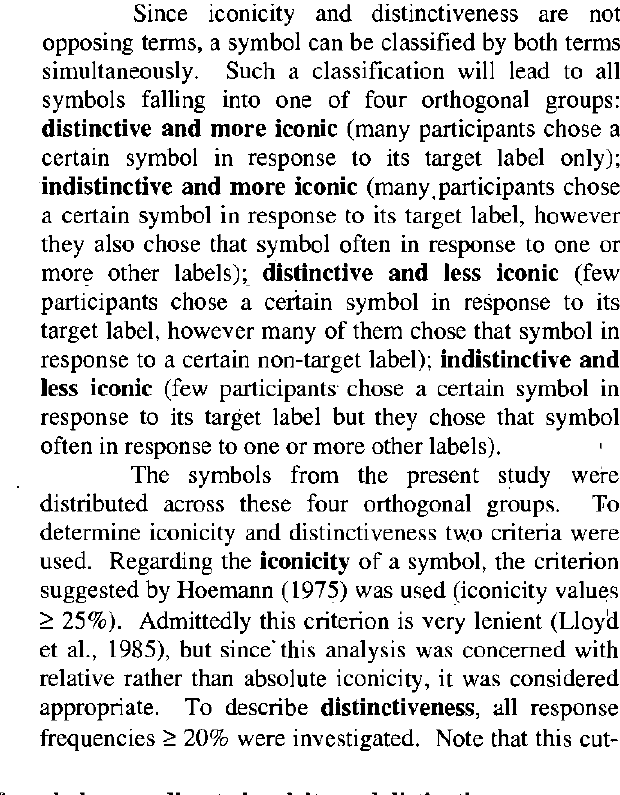
Table 3: Distribution of symbols according to iconicity and